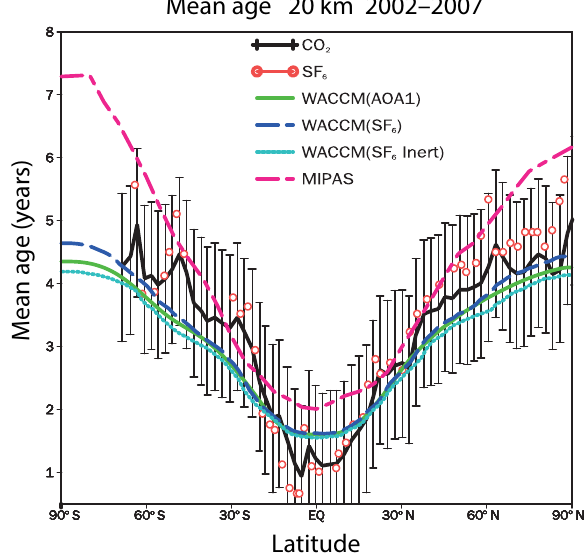
Figure 8. Mean age values at 20km altitude derived from MIPAS satellite (dashed magenta line) and ER-2 aircraft observations (SF 6 red open circles, CO 2 black crosses; Hall et al., 1999). The error bars apply to the age derived from the ER-2 observations. Also shown is the mean age derived from WACCM tracers: reactive SF 6 (dashed blue line), passive SF 6 (light blue line) and AoA tracer (AOA1, solid green line).